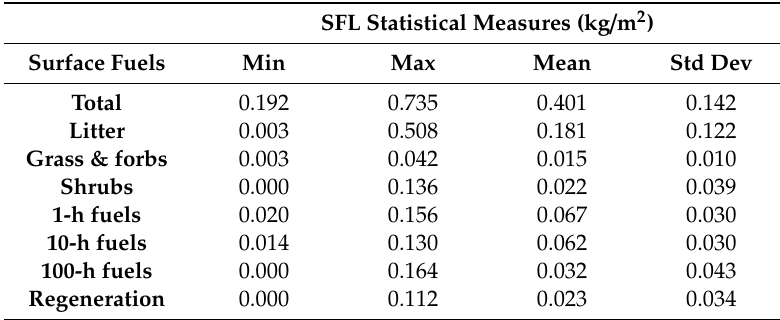
Table 1. A statistical summary of the field measured surface fuel load.